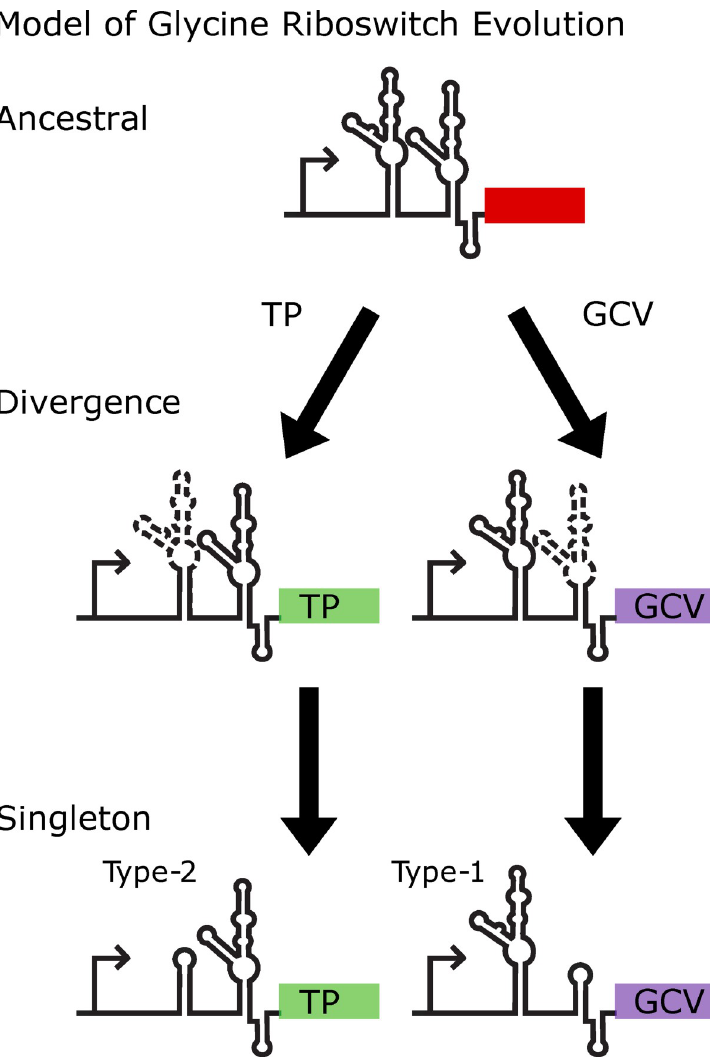
Fig 6. Model of glycine riboswitch evolution. Model proposed for the evolution and divergence of the glycine riboswitch. In this model a progenitor tandem riboswitch conserves one of the tandem aptamers based on the genomic context of the riboswitch, while the other slowly degrades down to the minimalistic components required for tertiary interaction to drive gene regulation. In this way, tandem glycine riboswitches may degrade into functional singleton tandem